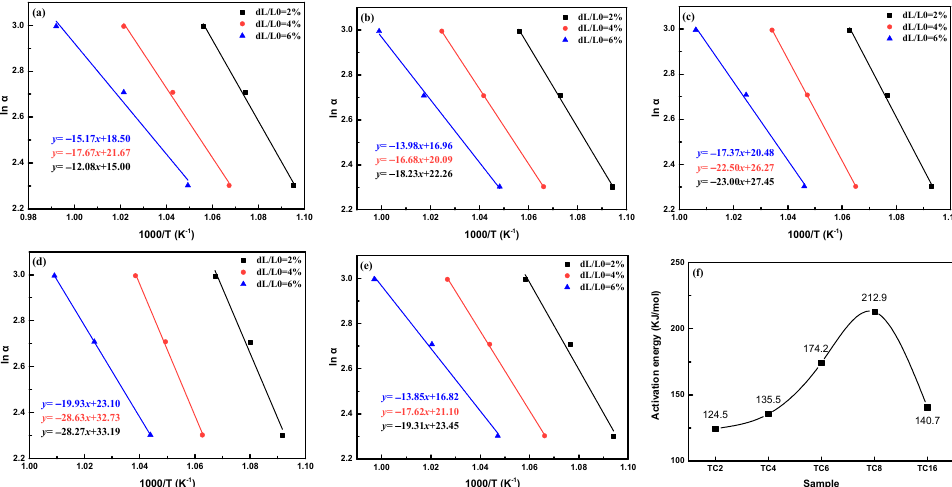
Figure 6. Fitted results of ln α ~1000/T plots and the sintering activation energy of the TC composites with various TC contents ( a ) TC2, ( b ) TC4, ( c ) TC6, ( d ) TC8, ( e ) TC16, and ( f ) the results of sintering activation energy of the TC composites.